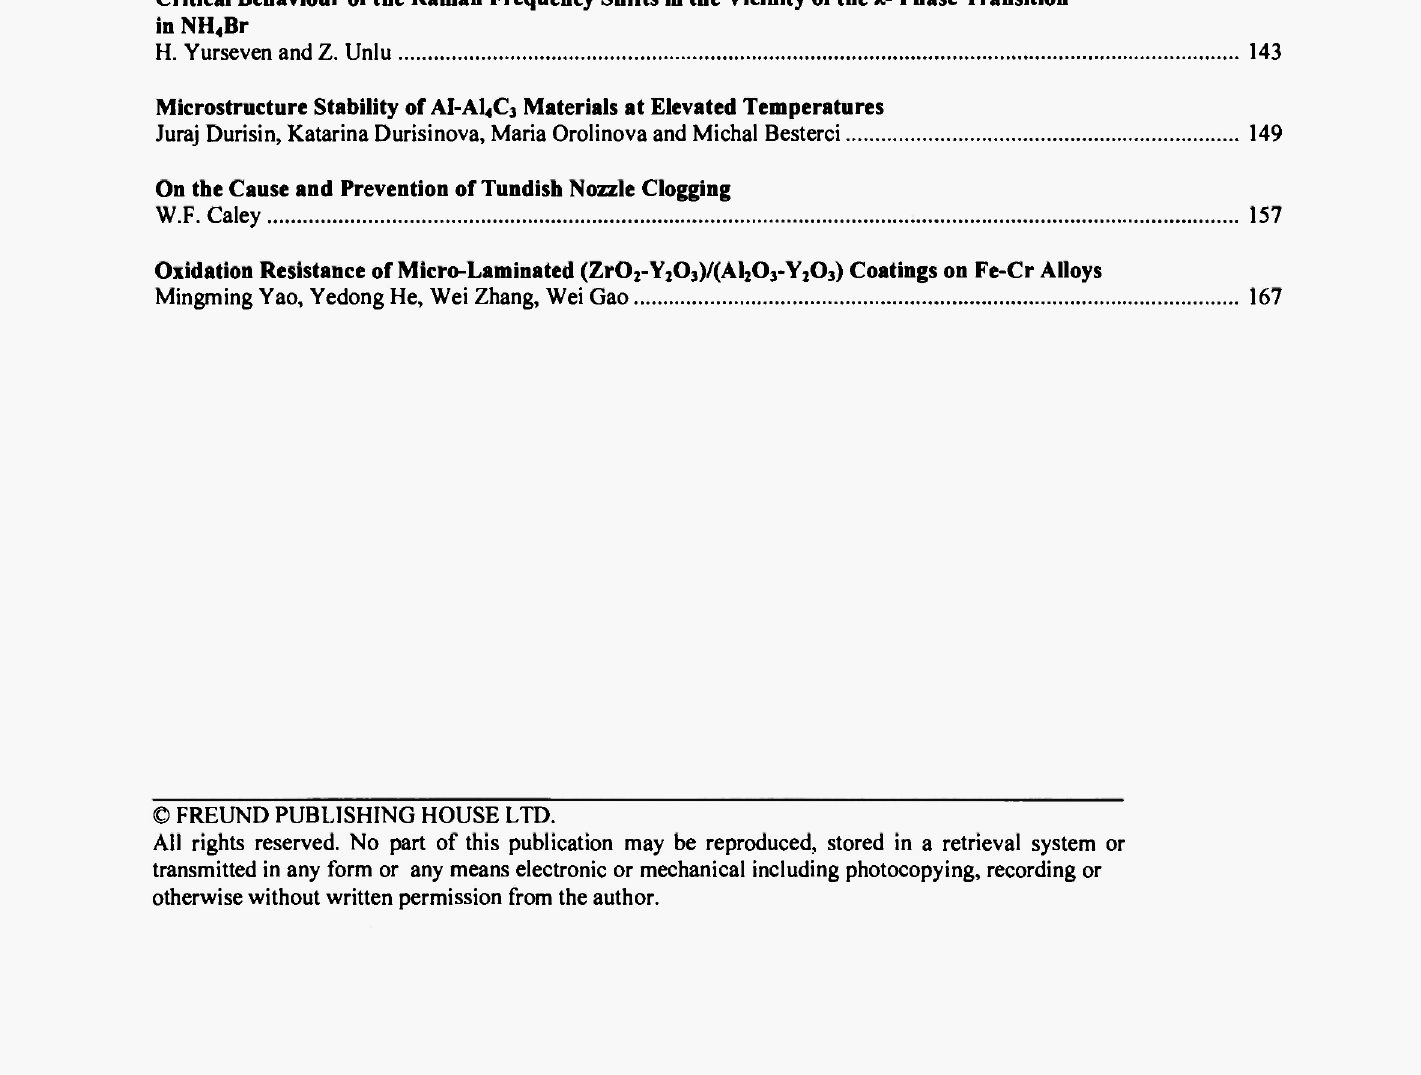
Critical Behaviour of the Raman Frequency Shifts in the Vicinity of the λ- Phase Transition in NH 4